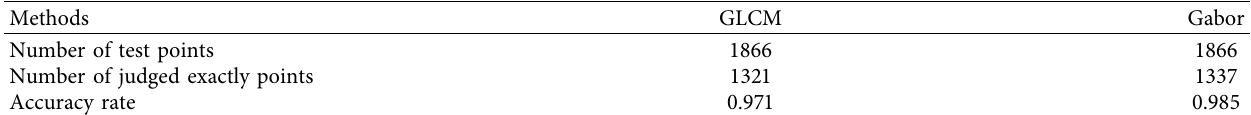
Figure 7: Comparison of initialization experiments of different Table 1: Accuracy judgment of contour feature points.